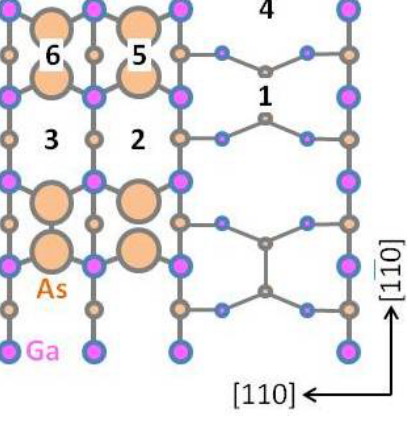
Figure 6. Plane view of GaAs(001)-(2 × 4) β 2. Adsorption sites for Ga are indicated by numbers. The migration barriers and desorption energies are presented in Table 3.